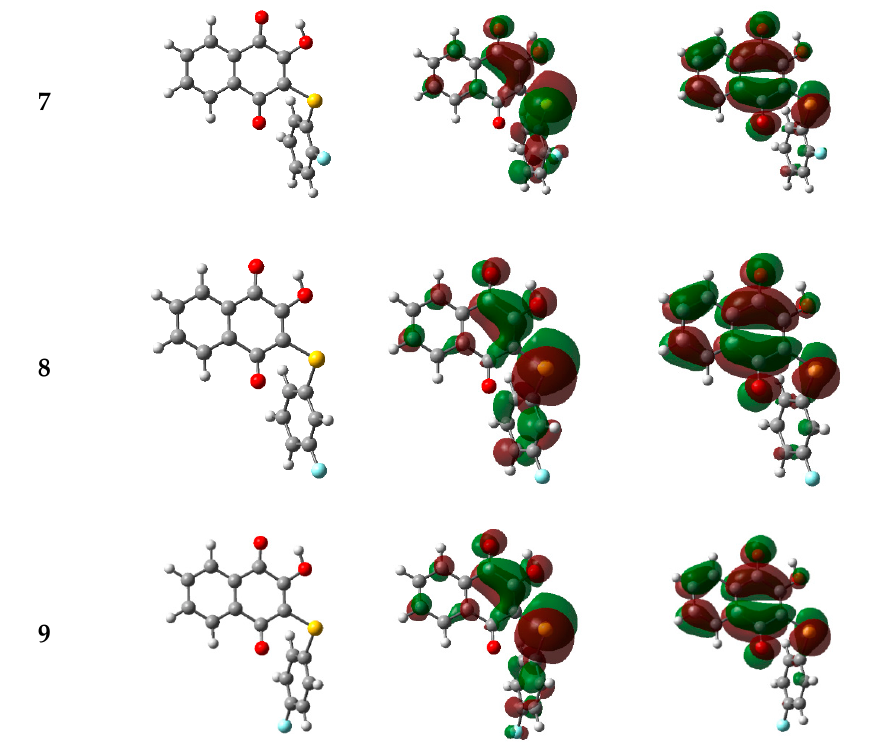
Figure 3. Optimized geometries and electronic densities corresponding to the HOMO and LUMO energy levels for all studied molecules.